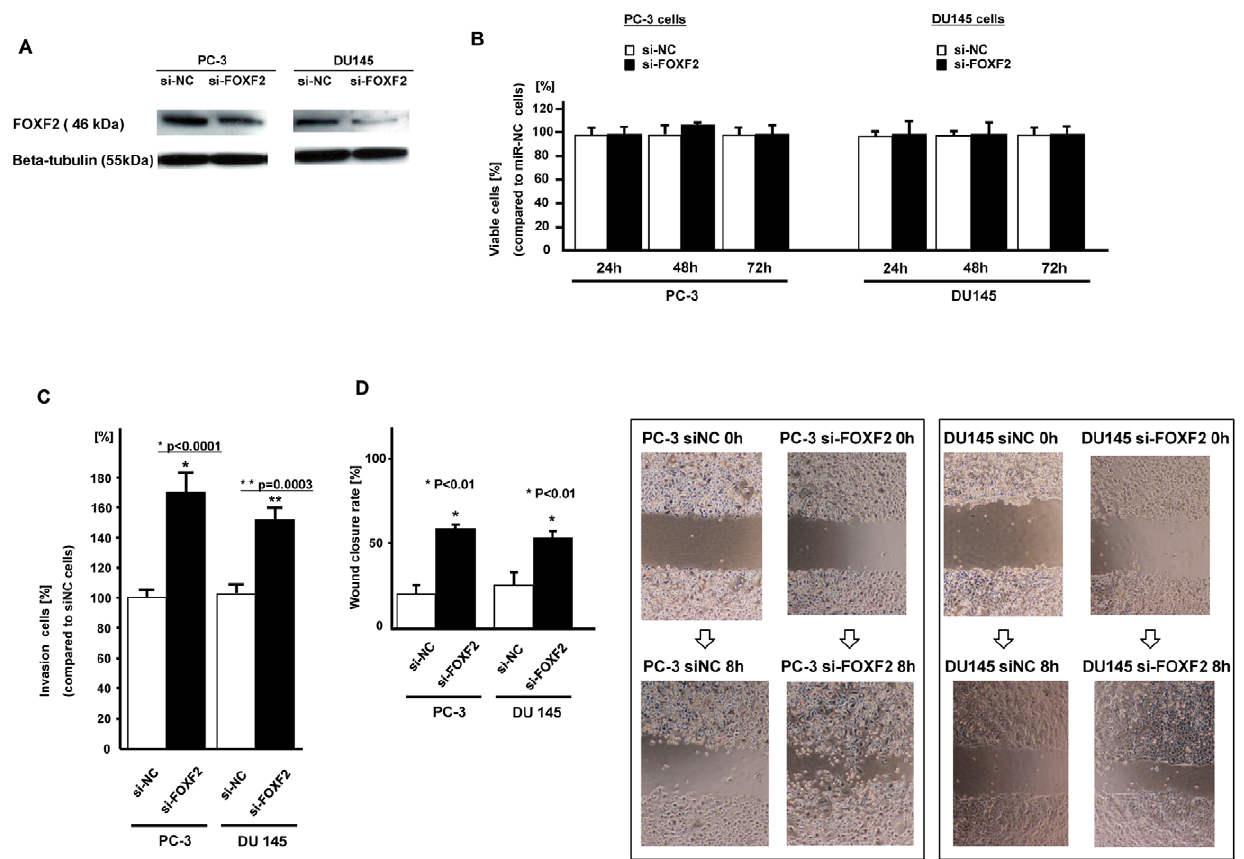
Figure 7. Effect of FOXF2 knockdown on prostate cancer cells (PC-3, DU145). A. FOXF2 protein expression (si-NC or si-FOXF2 transfected PC cells). B. Cell viability assay (si-NC or si-FOXF2 transfected PC cells). C. Invasion assay, D. Wound healing assay (8 hours), Error bars represent 6 S.D. (standard deviation).